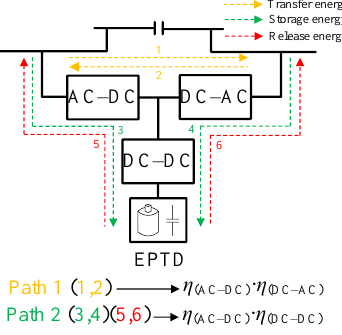
Figure 11. Typical topology and operation paths of EPTD.